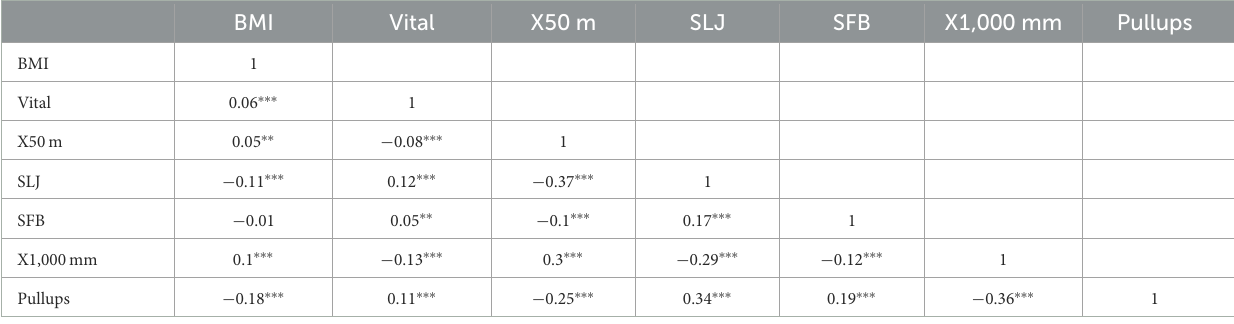
TABLE 2 Correlation matrix of the dependent variables ( N = 3,185).